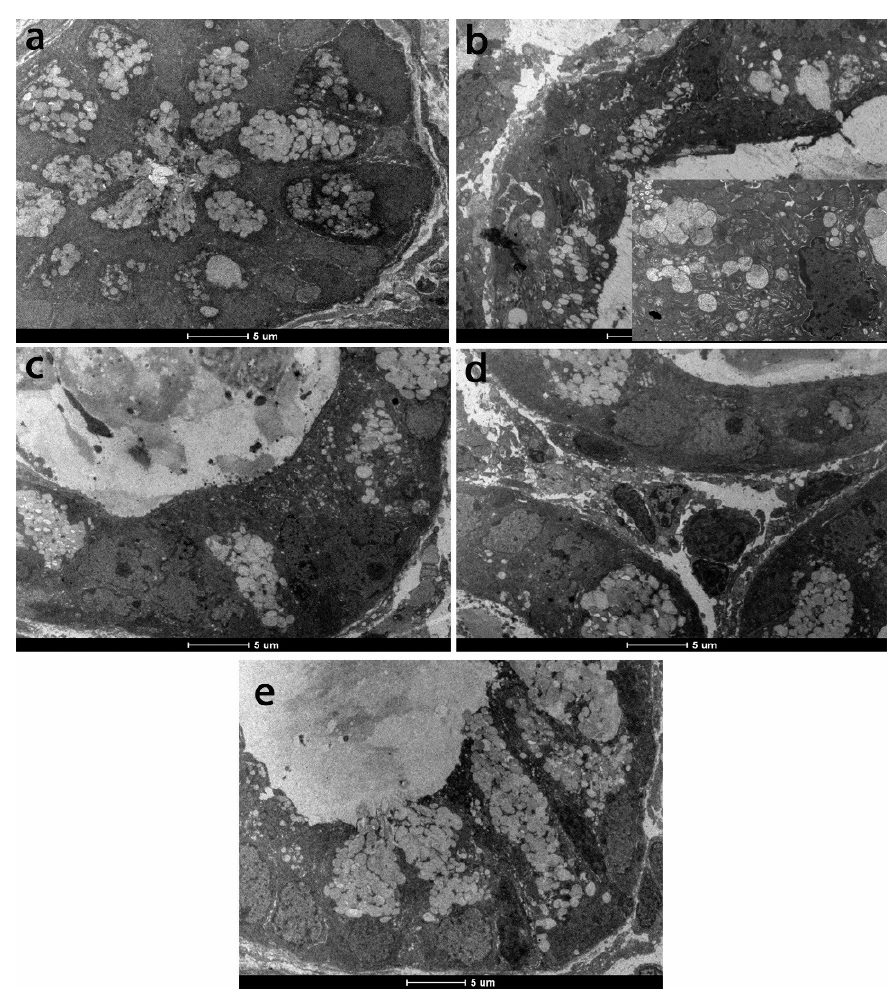
Figure 7. Ultrastructural appearance of intestinal mucosa in experimental groups: ( a ) Control; ( b ) TNBS; ( c ) TNBS + 5 mg Thuja occidentalis MT/kg of body weight; ( d ) TNBS + 25 mg Thuja occidentalis MT/kg of body weight; ( e ) TNBS + 50 mg Thuja occidentalis MT/kg of body weight.